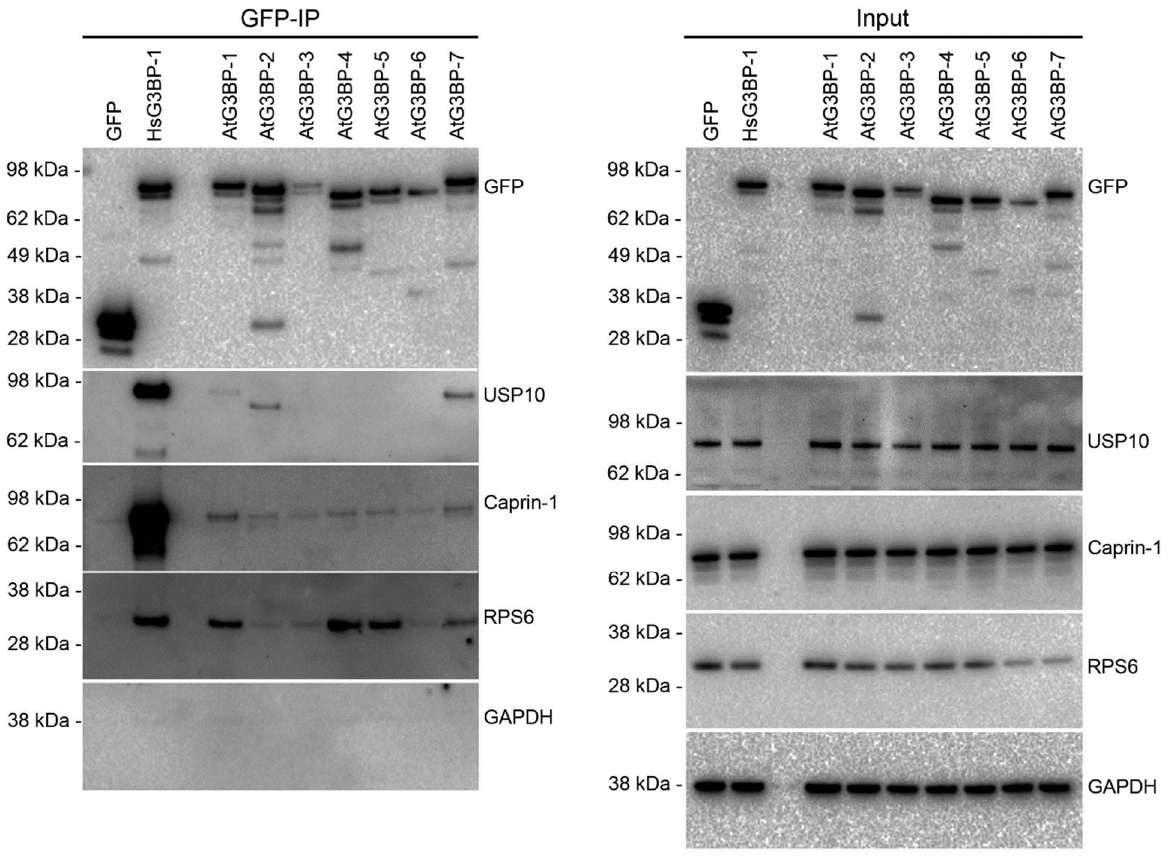
Figure 3. Identification of human interaction partners of the different AtG3BPs. GFP immunoprecipitates and cell lysates were analyzed by Western blot for GFP, USP10, Caprin-1, RPS6 or GAPDH.